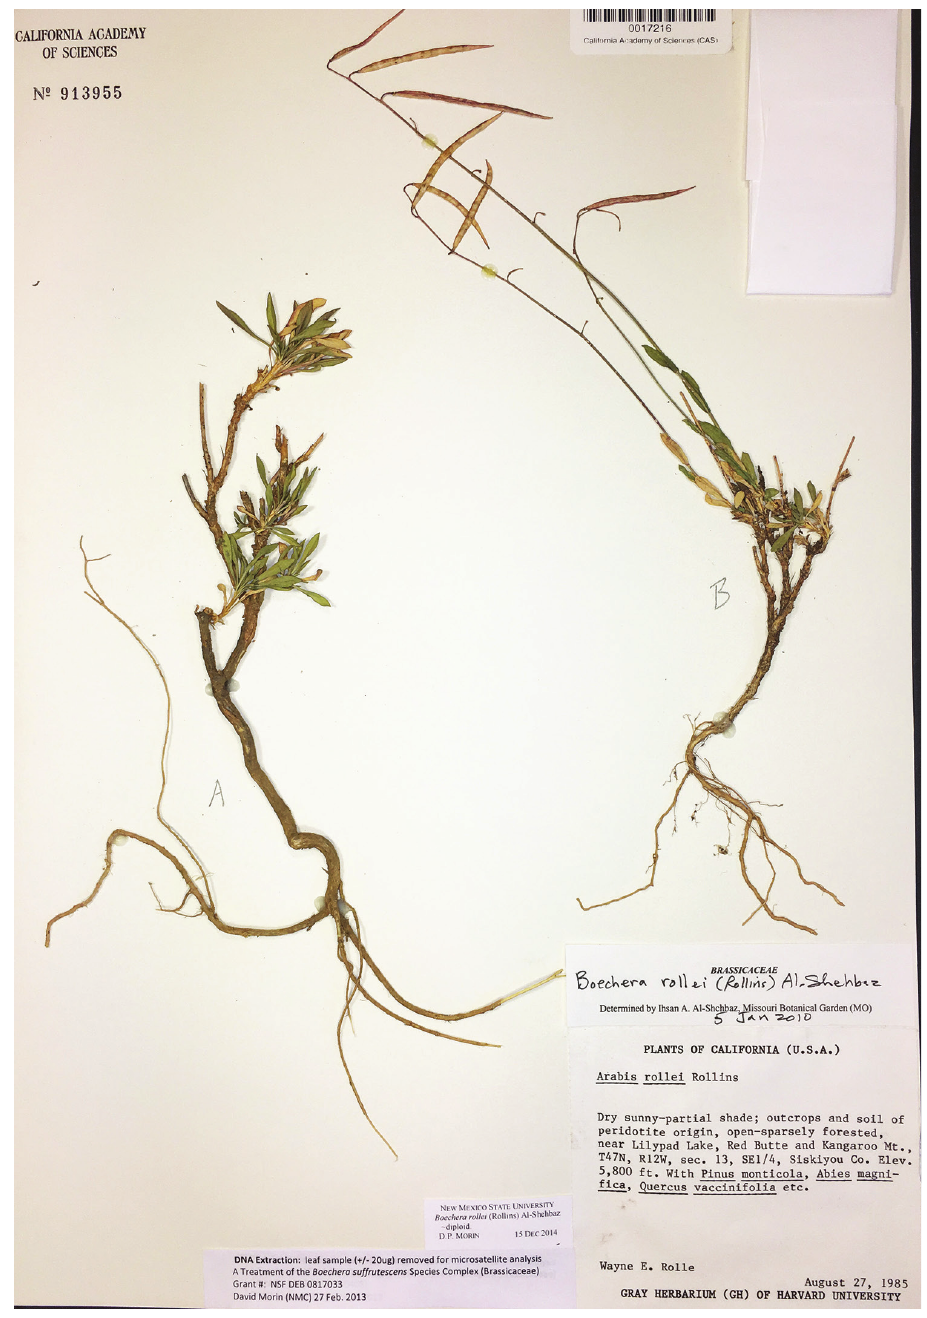
Figure 8. Boechera rollei , Rolle s.n.